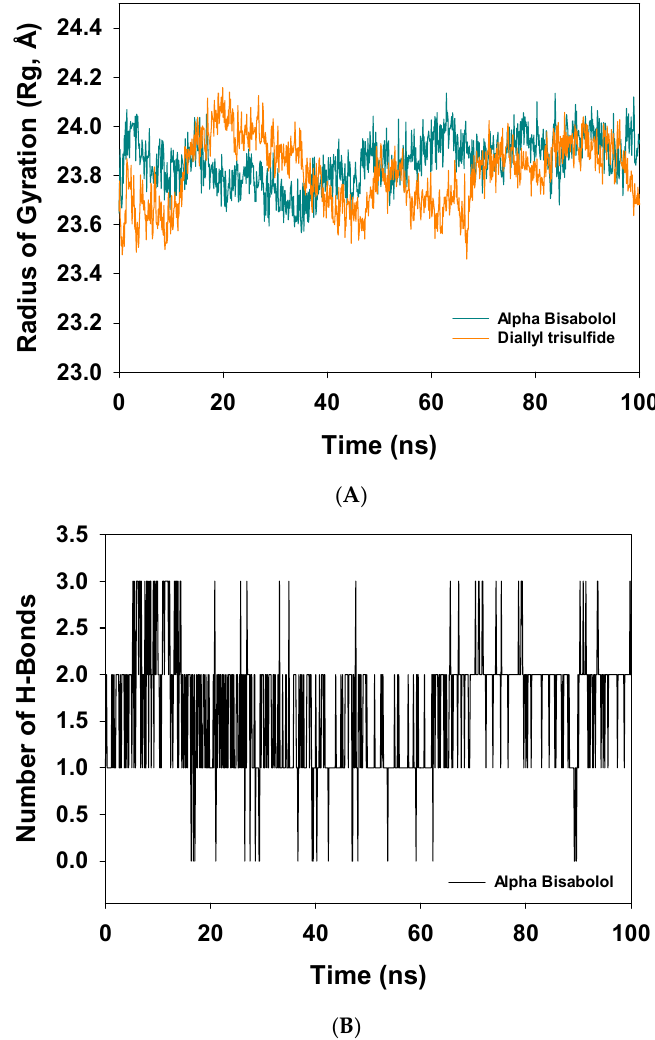
Figure 3. ( A ) Radius of gyration (Rg) plot of C α atoms of NADPH oxidase complexed with α -bisabolol (dark cyan) and diallyl trisulfide (orange). ( B ) Number of hydrogen bonds formed between NADPH oxidase and α -bisabolol throughout a simulation time of 100 ns.